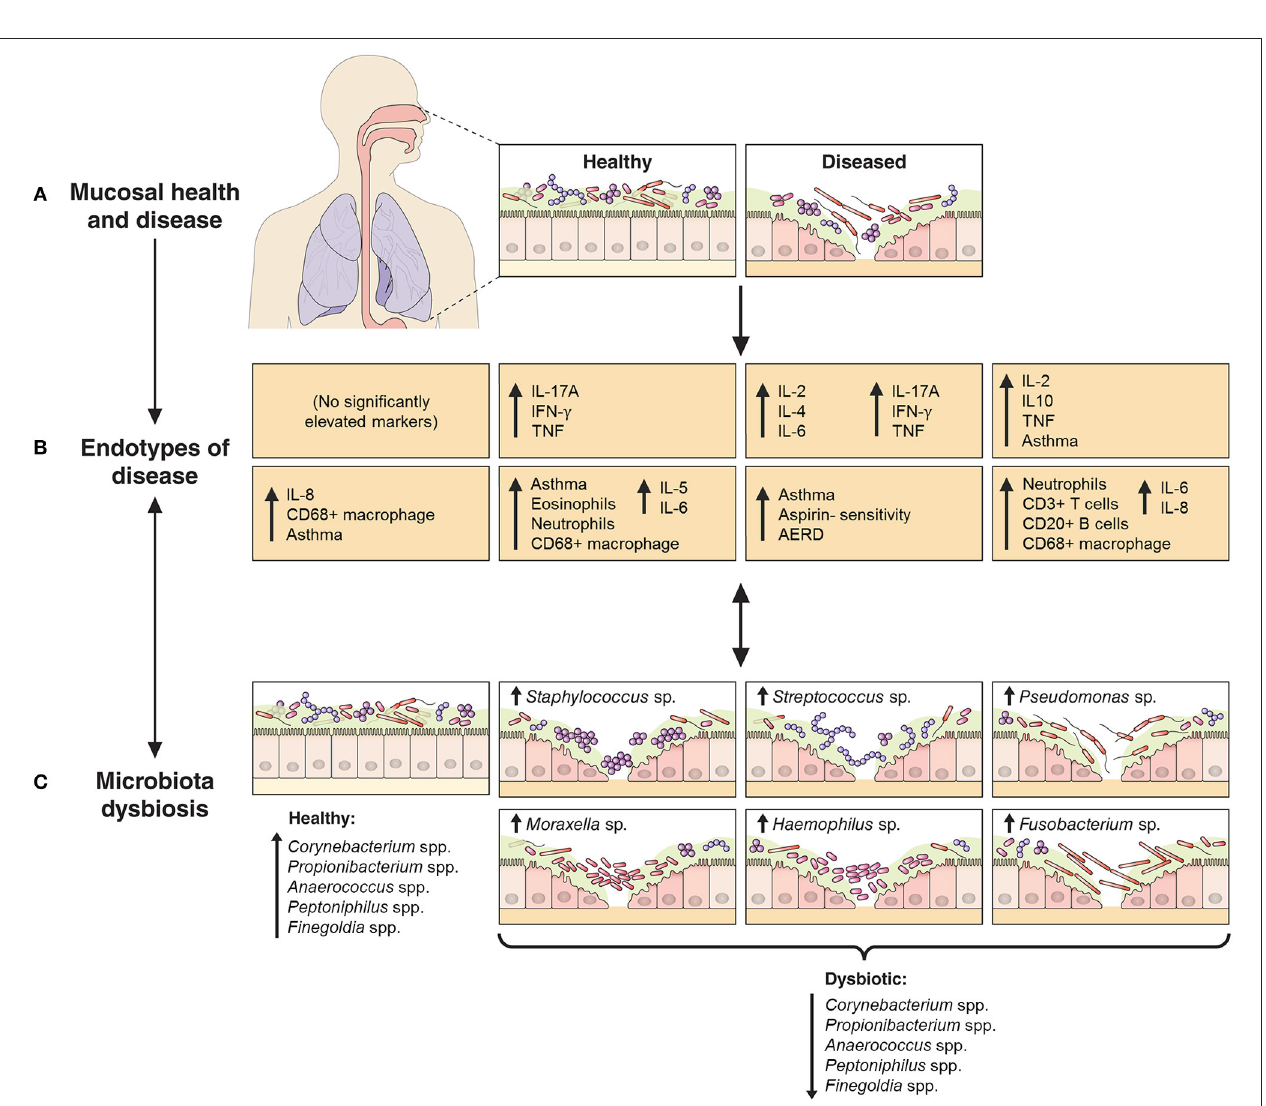
FIGURE 4 | dissimilarity), and co-occurrence patterns of bacterial OTUs, respectively: the clustering of the dendrogram branches indicates subjects or bacterial OTUs that are most similar to each other. Heat map values are shaded from white to black according to increasing relative sequence abundance of bacterial OTUs within each subject (white = 0%, black = 100%). Subject color codes are for (A) the phenotypic divisions of Controls ( n = 17), CRSsNP ( n = 46), CRSwNP ( n = 40), CRSwCF ( n = 7), and (B) the eight subject clusters identified in this study [SC1 ( n = 32), SC2 ( n = 16), SC3 ( n = 5), SC4 ( n = 4), SC5 ( n = 20), SC6 ( n = 16), SC7 ( n = 10), SC8 ( n = 7)]. ( B ) Heat map of Spearman correlations between key bacterial and immunological variables. Color-coding represents significant positive (blue; scale 0 to 1) and negative (red; scale 0 to − 1) correlations. Significance testing was based on upper tail probabilities, using the R function cor.test ( α = 0.05). Non-significant pairwise associations are uncolored. The dashed box in both denotes the group of eight “health-associated” bacterial OTUs discussed in this study.